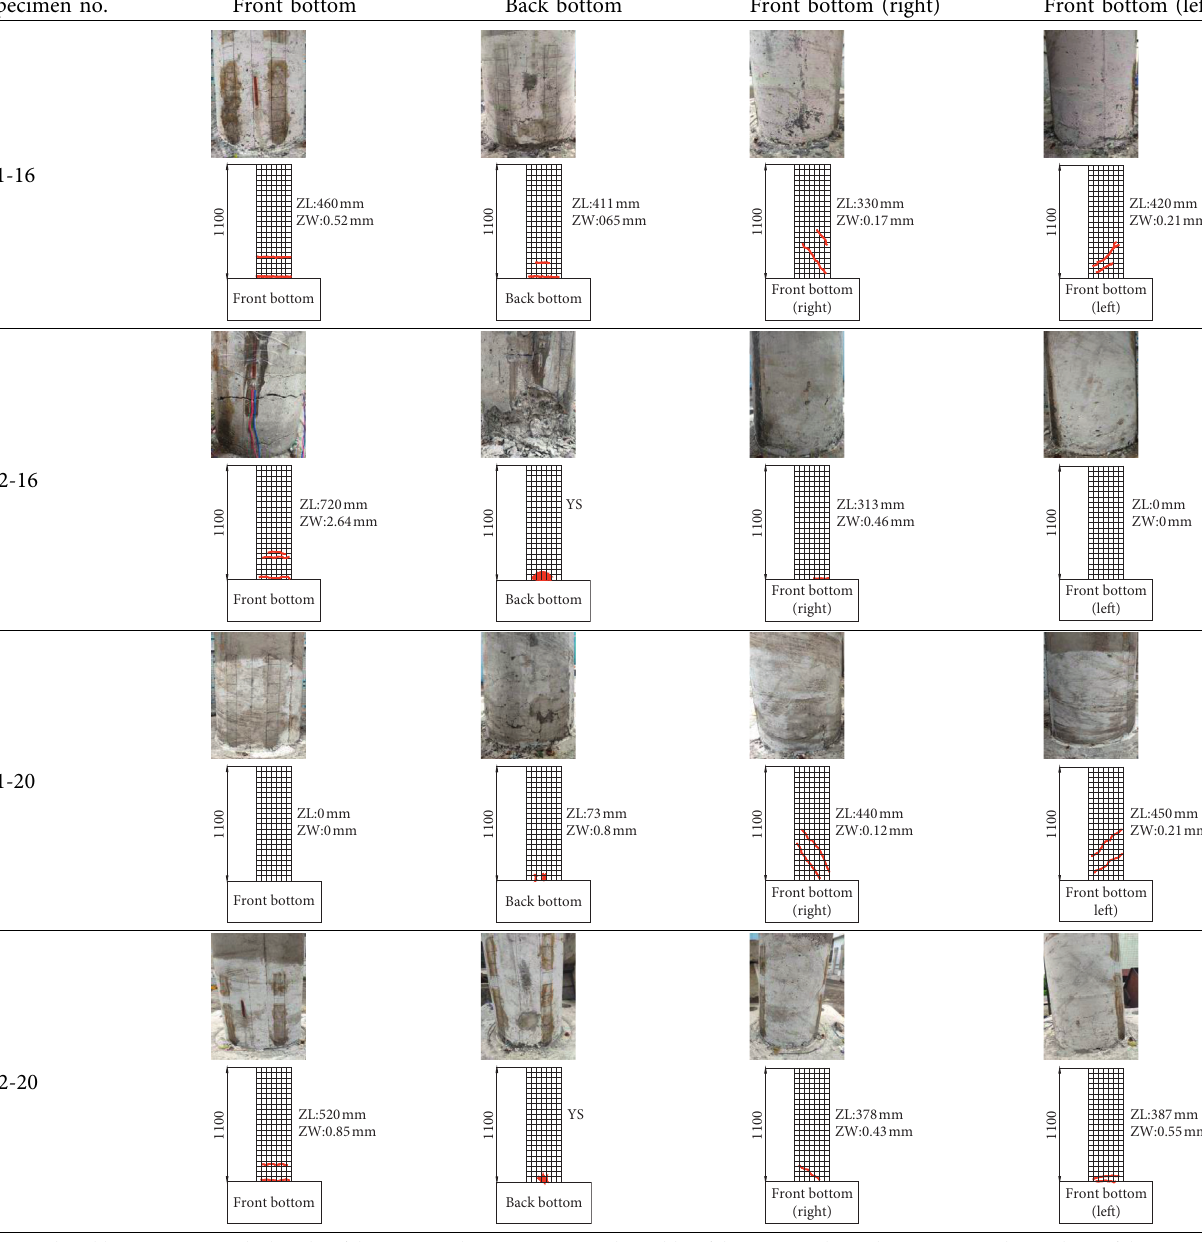
Table 10: Development and failure of the final cracks of each specimen. Specimen